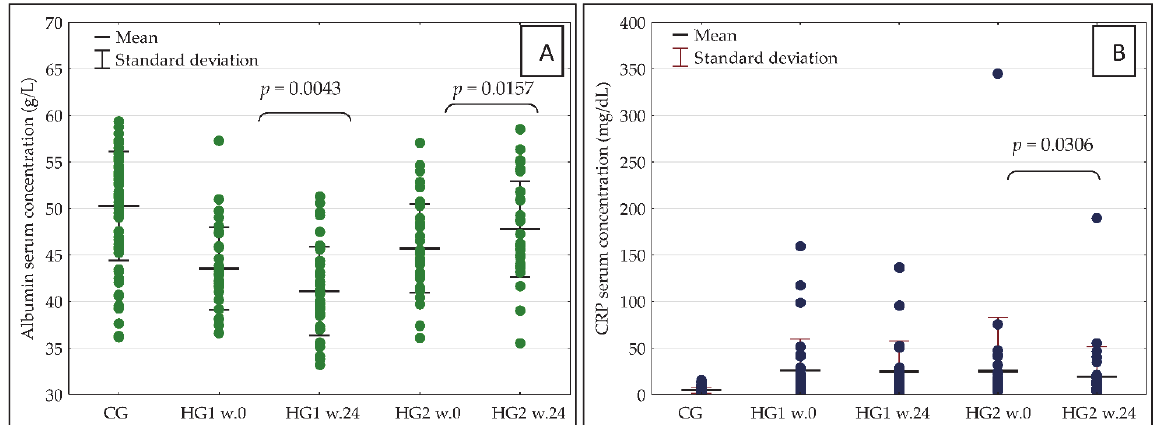
Figure 4. ( A , B ) Serum concentration of albumin ( A ) and CRP ( B ) in the studied groups of participants at baseline (week 0) and after 24 weeks of the dietary intervention. CRP—C-reactive protein; w.0—week 0; w.24—week 24; other abbreviations as in Figure 2. In week 0, there were no significant differences between HG1 and HG2 in the serum concentration of either albumin or CRP, but some differences were recorded in albumin concentration after 24 weeks of the nutritional intervention. More specifically, the concentration was significantly higher in HG2 ( p = 0.0000) than in HG1. In HG1, in